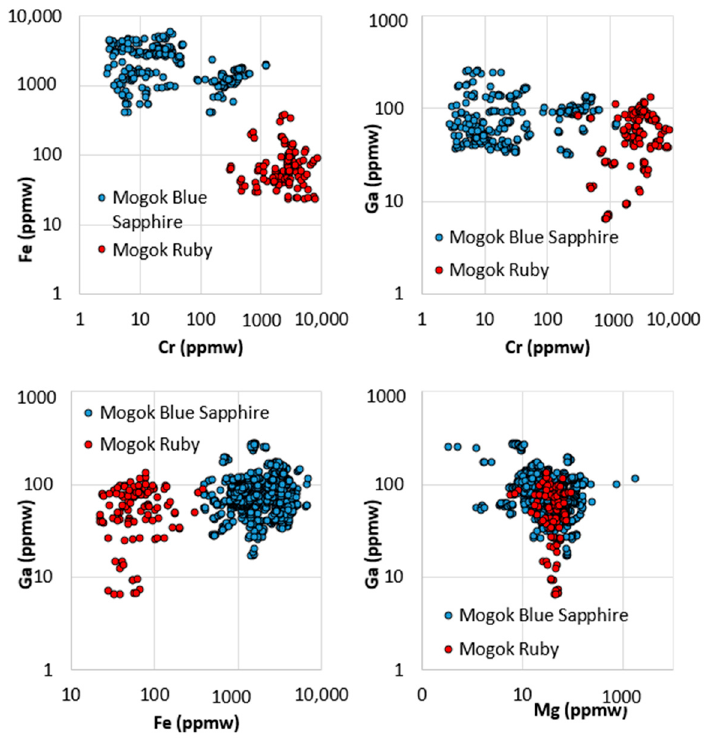
1 Table 6. Correlation table for trace elements of rubies from Mogok, Myanmar. Mg